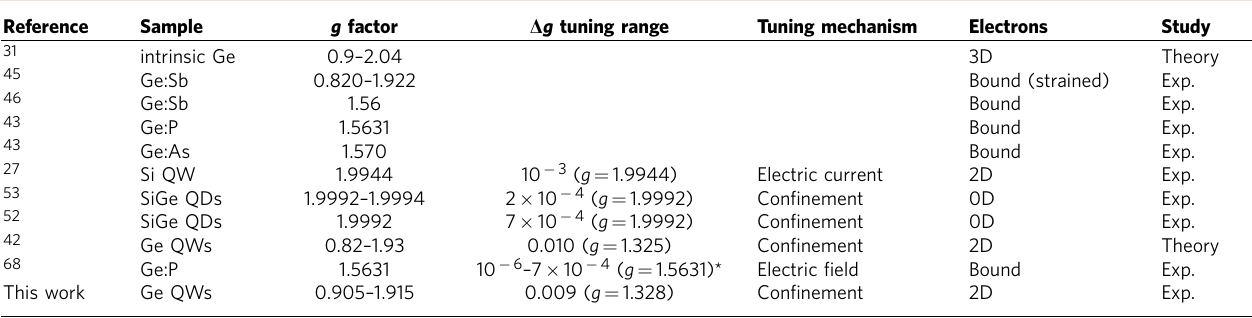
Table 1 | Electron g factor in Si–Ge materials systems.